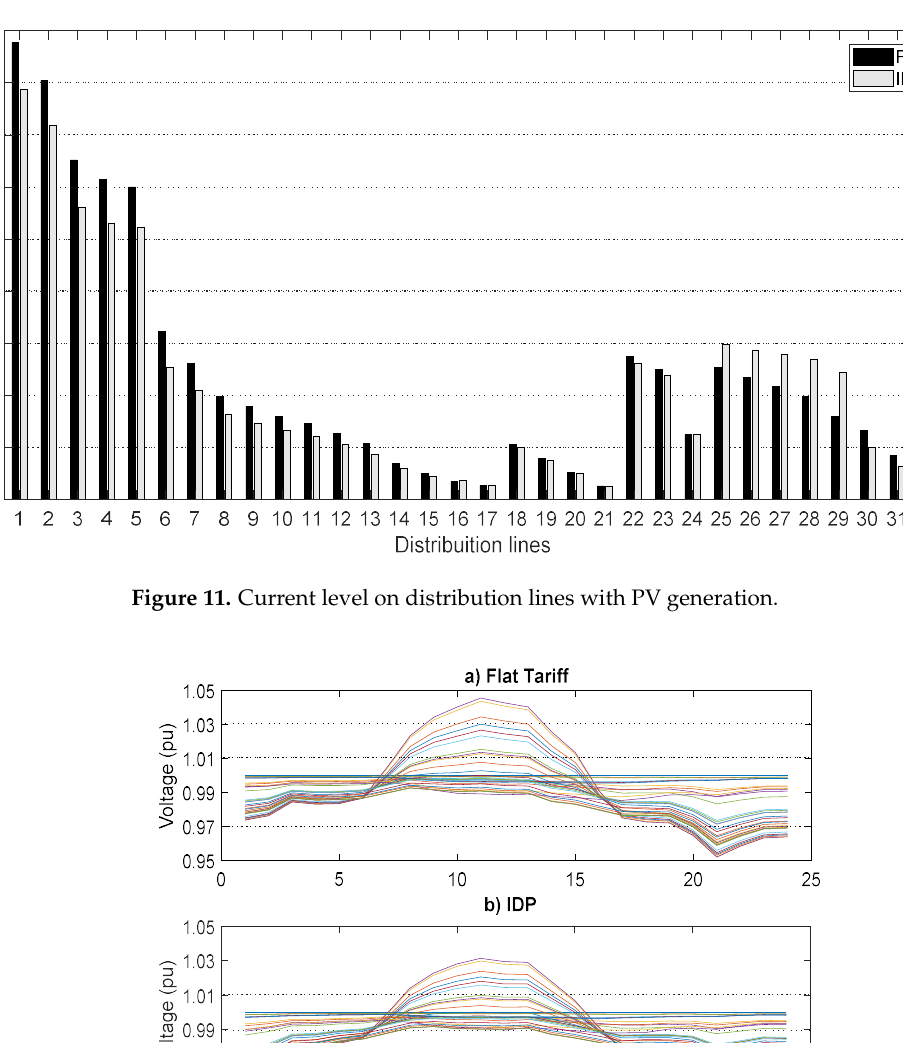
Figure 10. Tariff and Demand with renewable generation. ( a ) Bus 17 (residential). ( b ) Bus 18 (commercial).